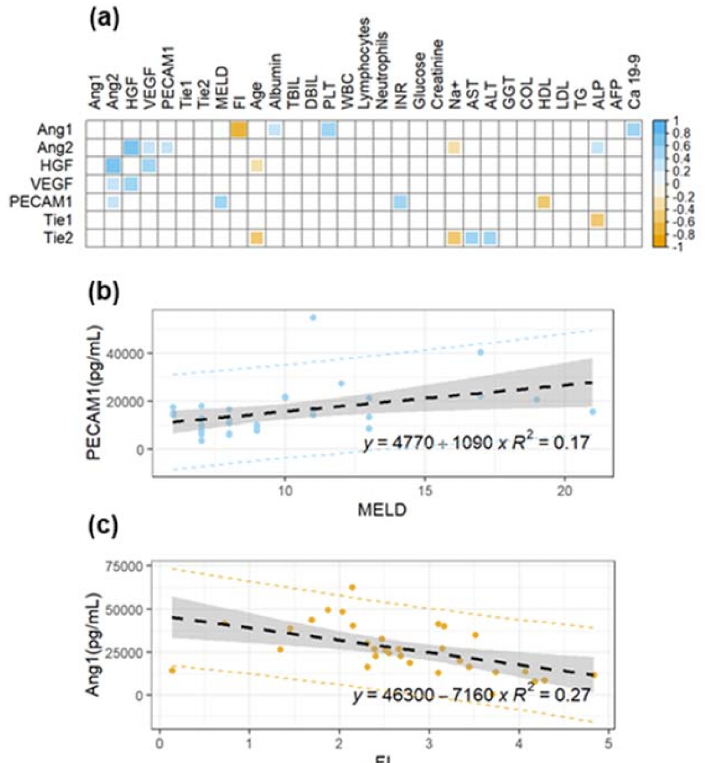
Figure 3. ( a ) Correlation matrix of Spearman’s coefficients, ρ , between the investigated angiogenesis markers and a panel of selected plasma biochemical parameters and clinical scores in a cohort of HCC patients. A double color scale is used to assess the direction of the correlations, with negative values displayed in orange and positive ones in light blue. The strength of the significant correlation is directly proportional to the pixel size and the pixel intensity. Non-significant correlations are indicated as empty white pixels. ( b ) Linear regression analysis of PECAM-1 as a function of MELD for the same subjects. ( c ) Linear regression analysis of Ang-1 as a function of MELD for the same